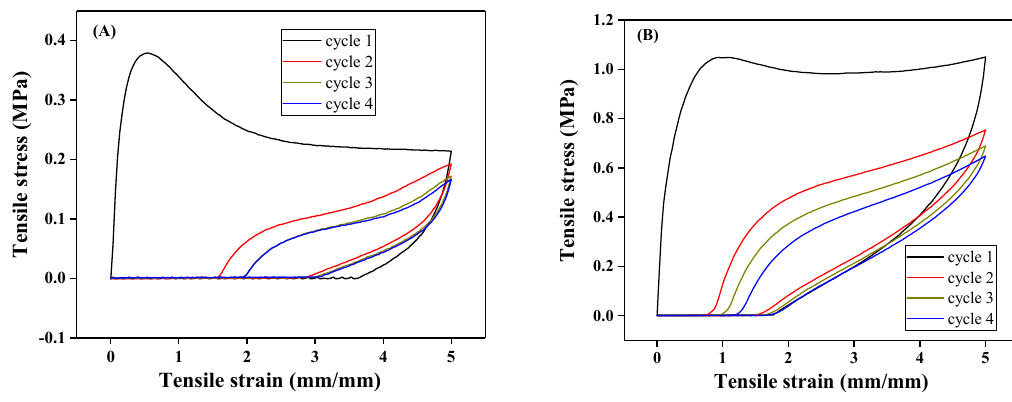
Figure 10. Cyclic tensile curves of P3-PU ( A ) and P7-PU ( B ) at a strain ε m = 500%.